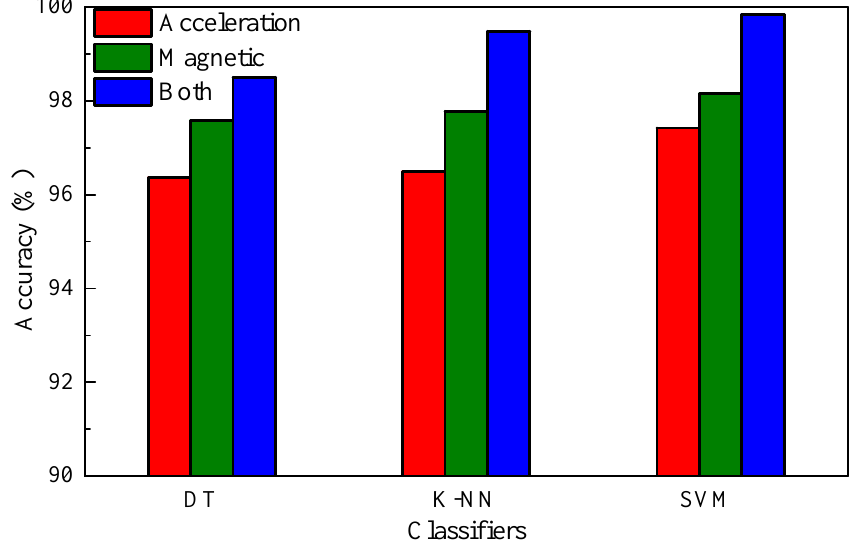
Figure 12. Accuracy of user’s activity